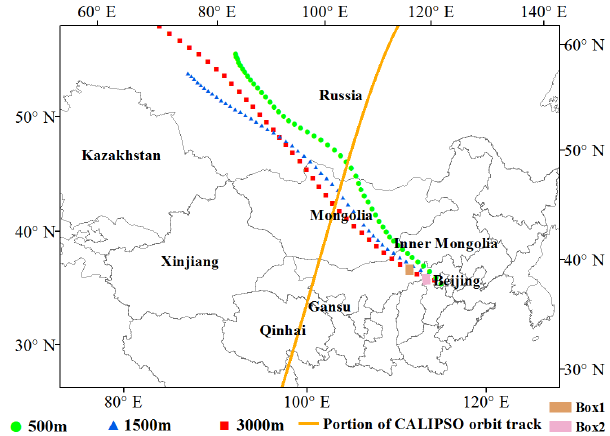
Figure 2. HYSPLIT 2 days back trajectory of air masses (dots) at three heights arriving at Beijing at 17:00 h on 15 April 2015 (local standard time), the yellow line represents the portion of CALIPSO orbit track on 14 April 2015 (UTC), the orange and pink box, respectively, represents the dust track passing through the city of Ulanqab and Zhangjiakou.